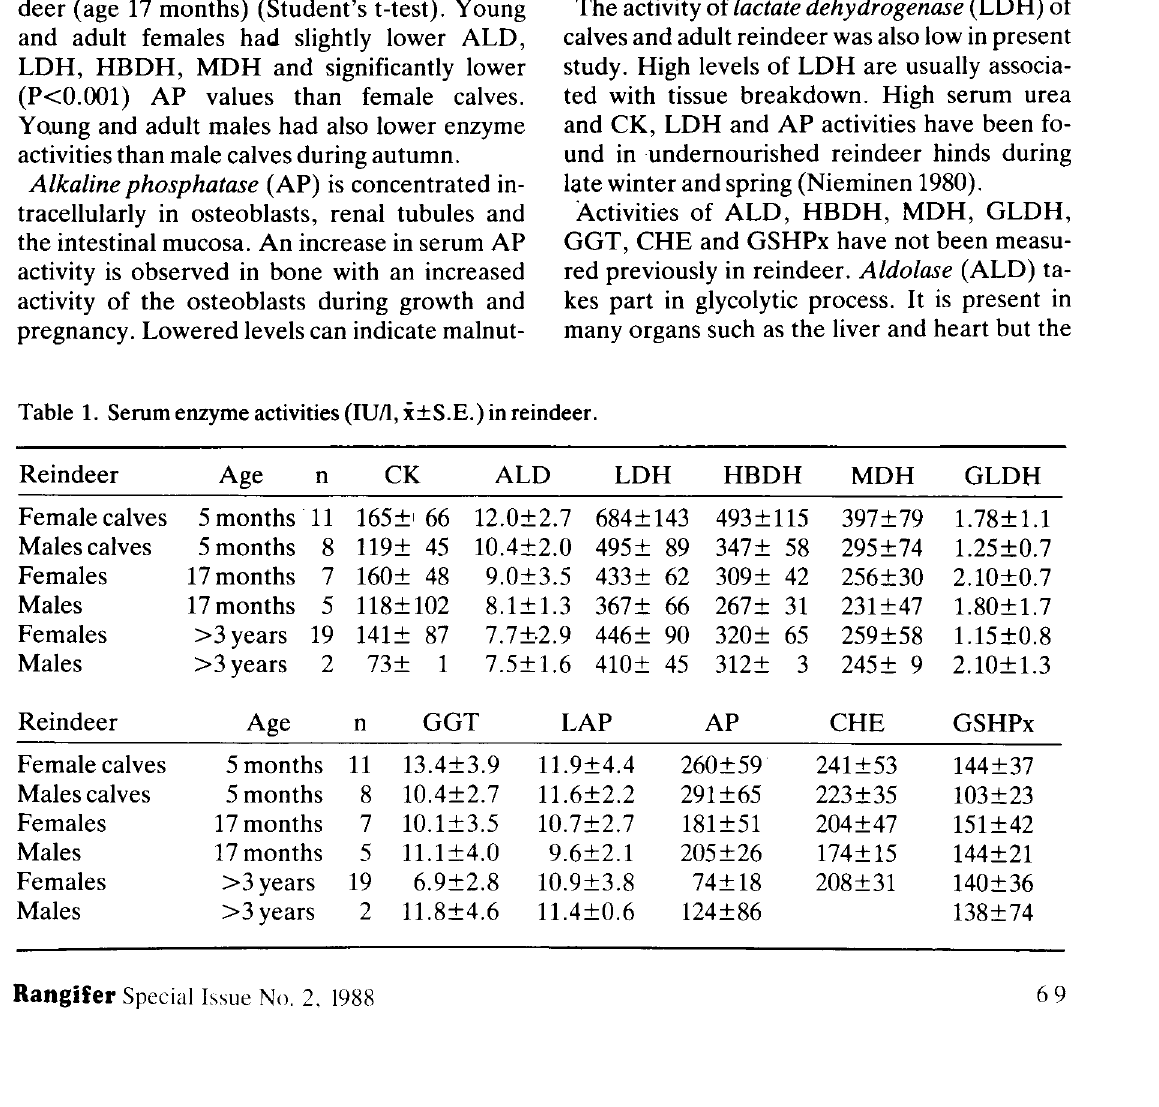
Table 1. Serum enzyme activities (IU/1, x±S.E.) in reindeer.